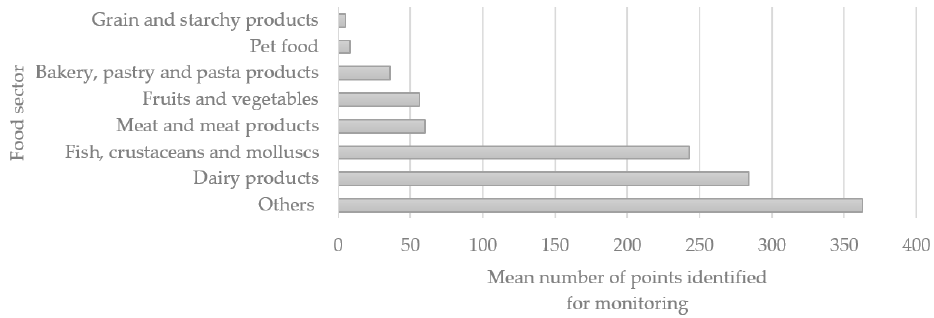
Figure 3. Mean number of sampling points in environmental monitoring in surveyed food facilities.